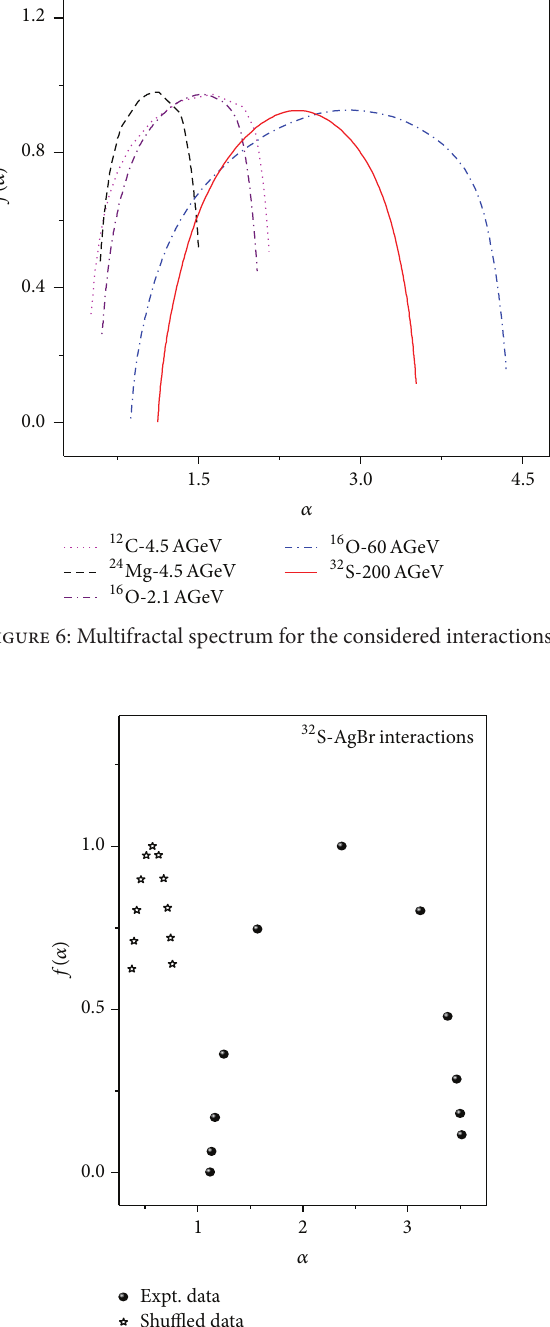
Figure 7: Comparison of multifractal spectrum for experimental and shuffled data for 32 S-AgBr interactions at 200